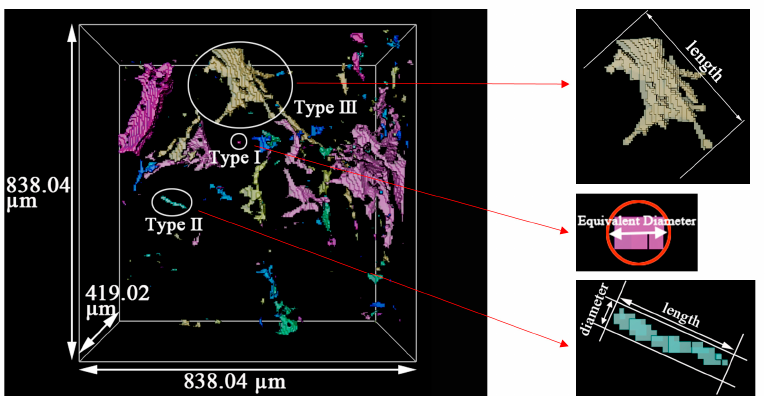
Figure 2. The 3D images of typical pores (on the left), such as round-shaped (Type Ⅰ ) pores, long strip (Type Ⅱ ) pores and branched crack-like (Type Ⅲ ) pores. The length of Type Ⅱ and Ⅲ pores, the diameter of Type Ⅱ pores and the Equivalent Diameter of Type Ⅰ pores (on the right).